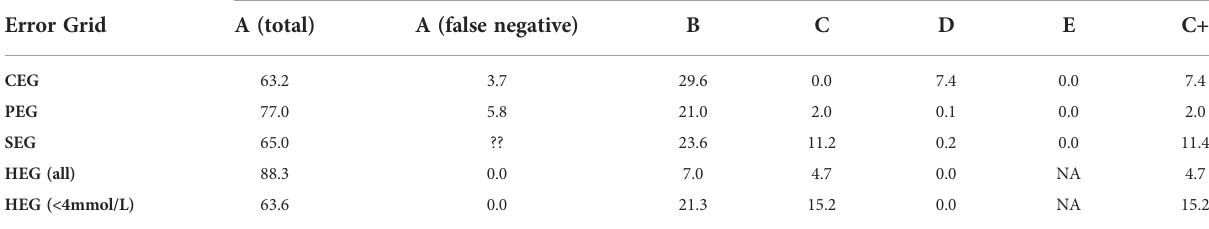
TABLE 3 Comparison of percentage risk allocated to each category between error